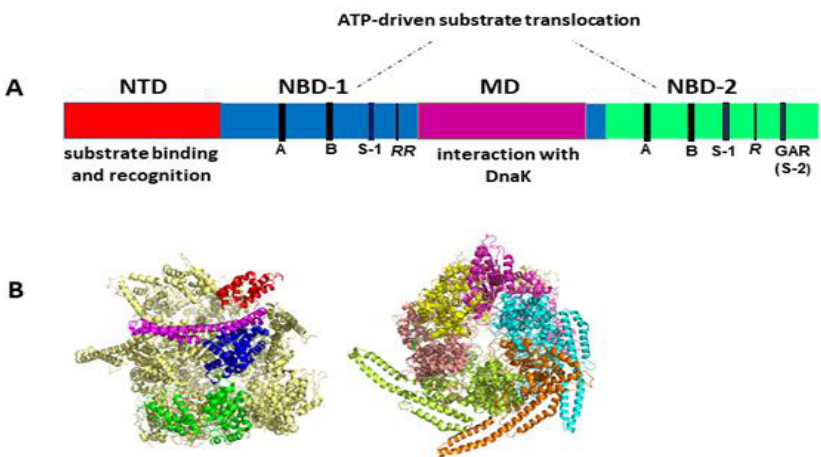
Figure 1. ( A ) Structural organization of the ClpB monomer. Four domains are indicated: N-terminal domain (NTD), two nucleotide-binding domains (NBD-1 and NBD-2), and middle domain (MD). Each NBD contains the characteristic AAA+ motifs: Walker A (GX 4 GKT/S) ( A ), Walker B (Hy 2 DE) (B), sensor-1 (S-1), sensor-2 (S-2, GAR), and the arginine fingers ( R ). ( B ) Cryo-EM structure of hexameric Hsp104 from S. cerevisiae in the closed conformation (PDB entry 6N8T) [30]. Left panel: side view with the structural domains indicated for one Hsp104 subunit: NTD (red), NBD-1 (blue), MD (magenta), and NBD-2 (green). Right panel: top view with each subunit shown in a different color. The substrate-processing channel is visible at the center of the structure. Three out of six MDs were resolved in this cryo-EM image analysis, which highlights the highly dynamic properties and structural asymmetry of the hexameric complex. Images generated using PyMol 1.3 (Schrödinger LLC, www.pymol.com accessed on 2010).